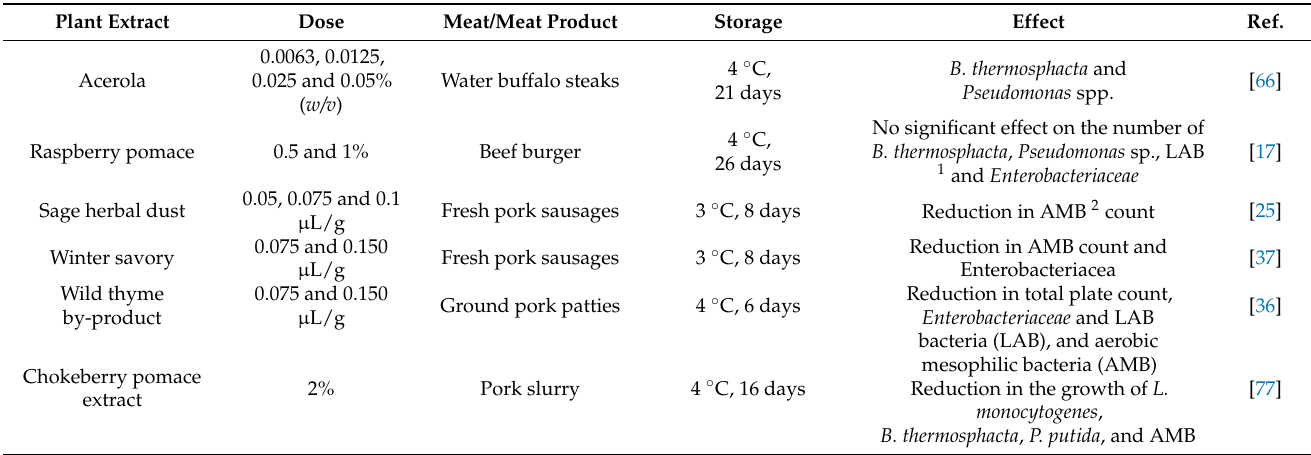
Table 3. Antimicrobial effect of supercritical fluid extracts in meat and meat